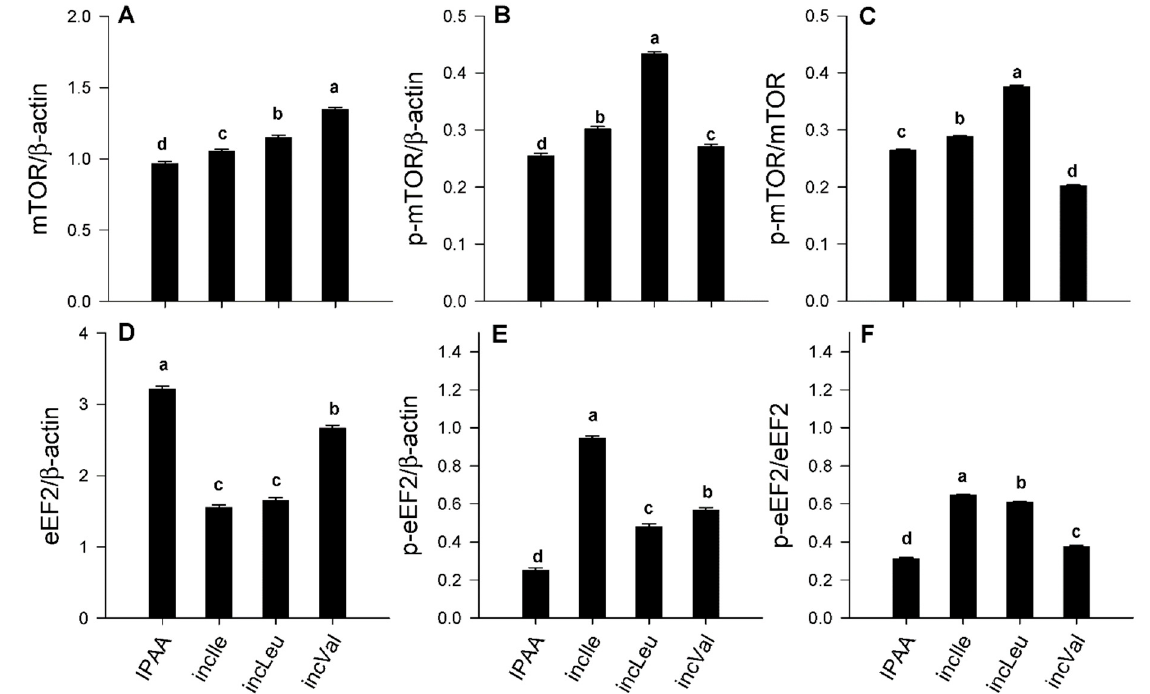
Figure 2. Protein abundance (relative to β -actin) of mechanistic target of rapamycin (mTOR; total, panel ( A )), p-mTOR (active, panel ( B )), ratio of p-mTOR/mTOR (panel ( C )), eukaryotic elongation factor 2 (eEF2; total, panel ( D )), p-eEF2 (active, panel ( E )), and ratio of p-eEF2/eEF2 (panel ( F )) in s.c. adipose tissue cultured with different levels of Leu, Ile, or Val. Control media contained an ideal AA profile (IPAA; Lys:Met 2.9:1, Lys:Val 1.23:1; Lys:Ile 1.45:1; Lys:Leu 0.85:1). Treatment media was supplemented with greater amounts of Leu, Ile, or Val to achieve ratios of Lys:Leu 0.78:1 (incLeu), Lys:Ile 1.29:1(incIle), or Lys:Val 1.12:1 (incVal). Different letters indicate differences between treatments ( p < 0.05) using the Tukey multiple comparison procedure in SAS v.9.4 (SAS Institute Inc., Cary, NC, USA). Data are LS means, n = 4 cows per group, ± pooled SEMs.